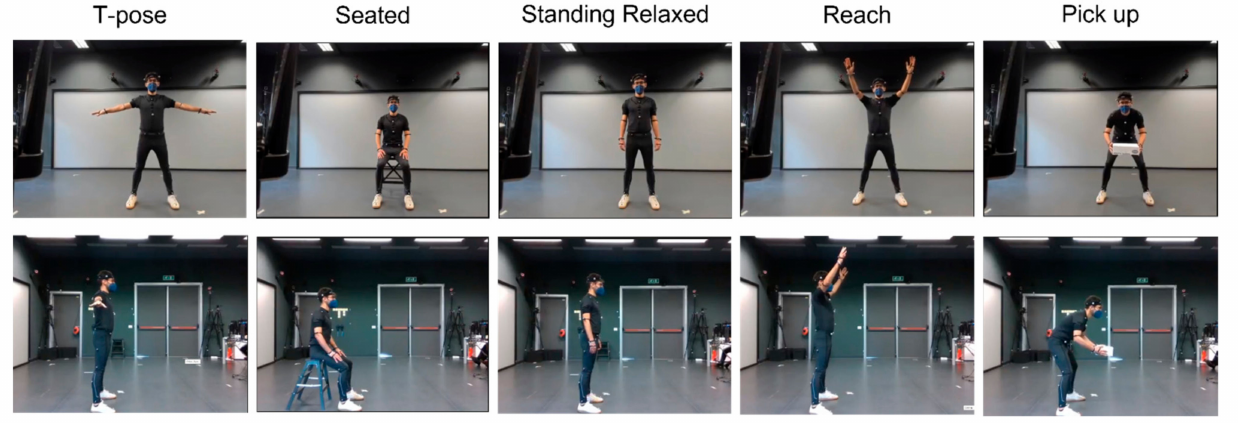
Figure 3. Postures assessed in this research